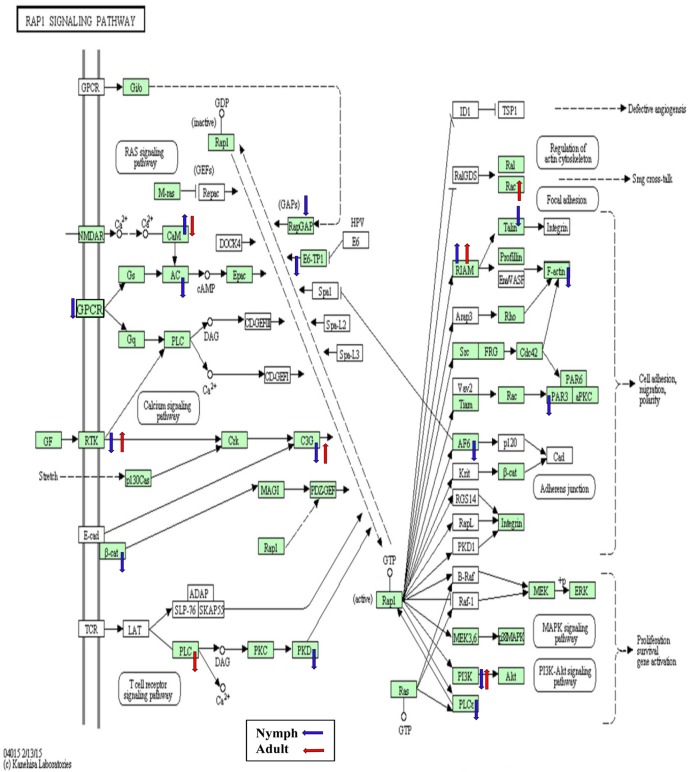
The Rap 1 signaling KEGG pathway diagram showing the contigs that were differentially expressed (p<0.05) in nymphs (blue arrows) and adults (red arrows) in response to CLas infection.Of the assigned contigs (shaded in green), 18 were differentially expressed either in the nymphs or adults.